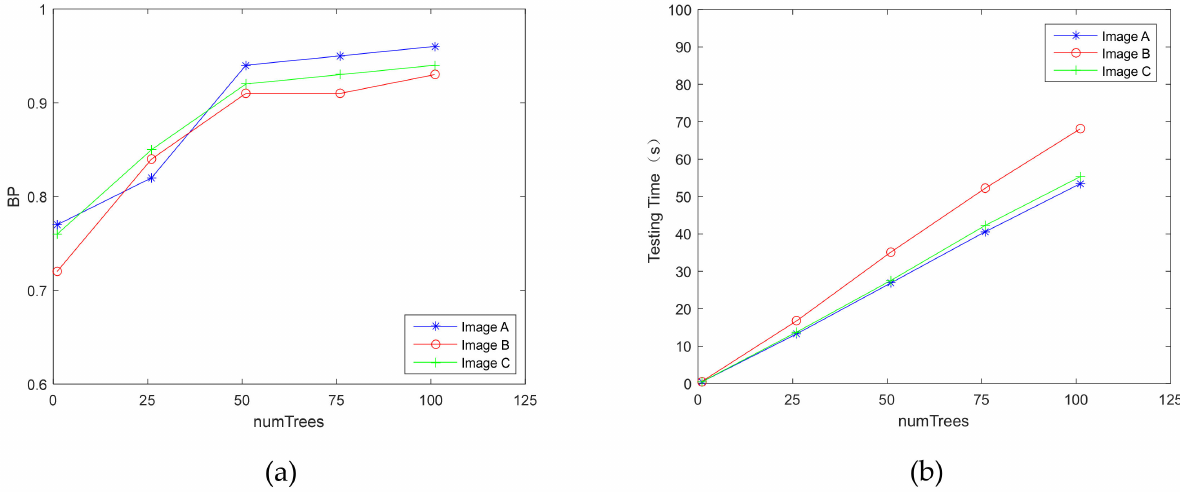
Figure 7. Performance of HMRF affected by the number of trees: ( a ) boundary precision (BP) performance on HMRF and ( b ) execution time on